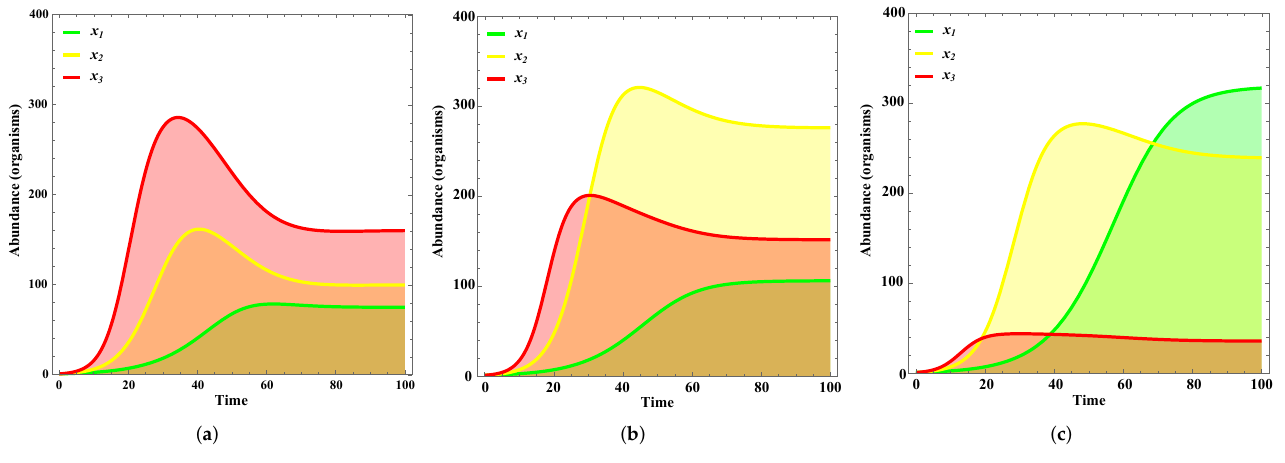
Figure 3. Behavior of AM population densities. In all cases; m = 14.5, r 1 = 0.1, r 2 = 0.2, r 3 = 0.3, β 1 = 1 ∗ 10 − 3 , β 2 = 1 ∗ 10 − 4 , β 3 = 1 ∗ 10 − 5 , γ 1 = 1 ∗ 10 − 4 , γ 2 = 1 ∗ 10 − 5 , γ 3 = 1 ∗ 10 − 6 , and the initial conditions are the same, except ( a ) k 1 < k 2 < k 3 and r = 0.2 (poor water quality), ( b ) k 1 < k 3 < k 2 and r = 2.5 (regular water quality), and ( c ) k 3 < k 2 < k 1 and r = 10.5 (good water